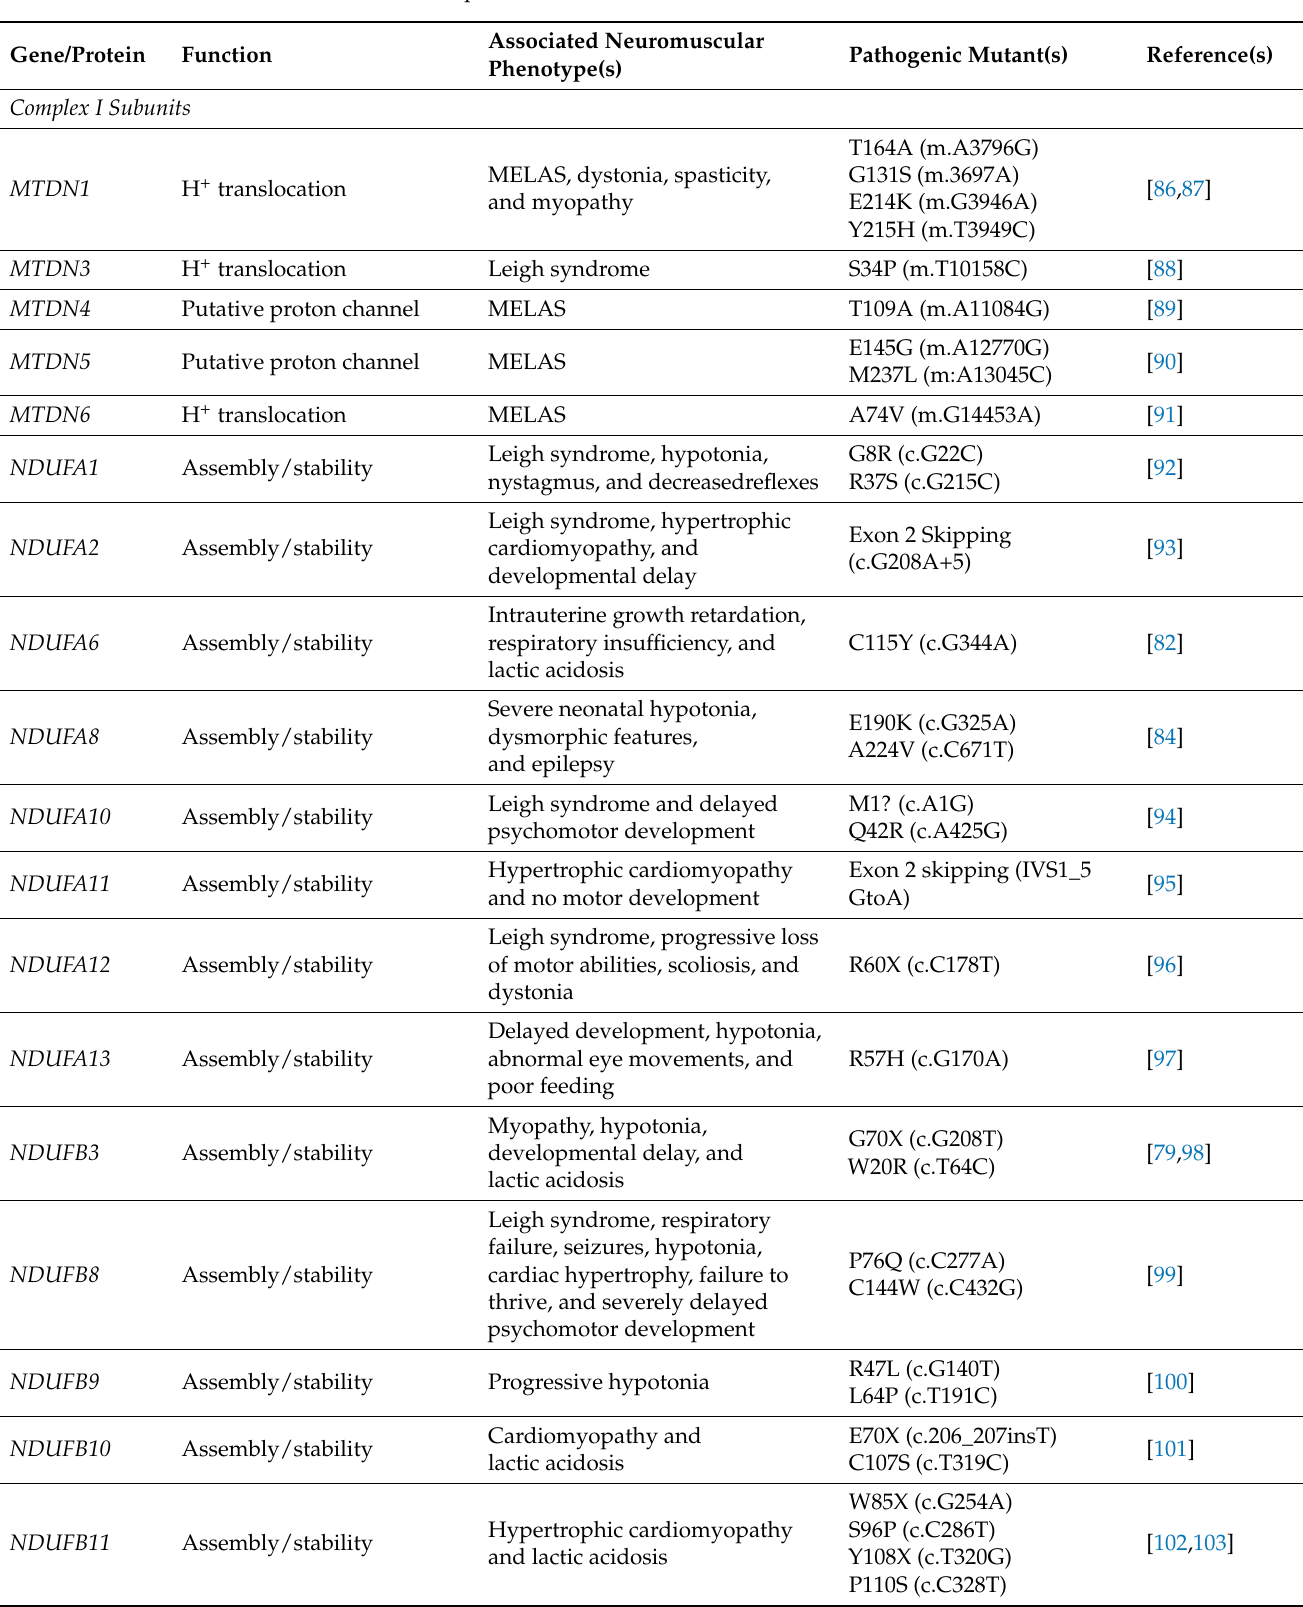
Table 1. Impaired mitochondrial respiratory complex subunits associated with neuromuscular phenotypes. Their amino acids and nucleotide mutations are also